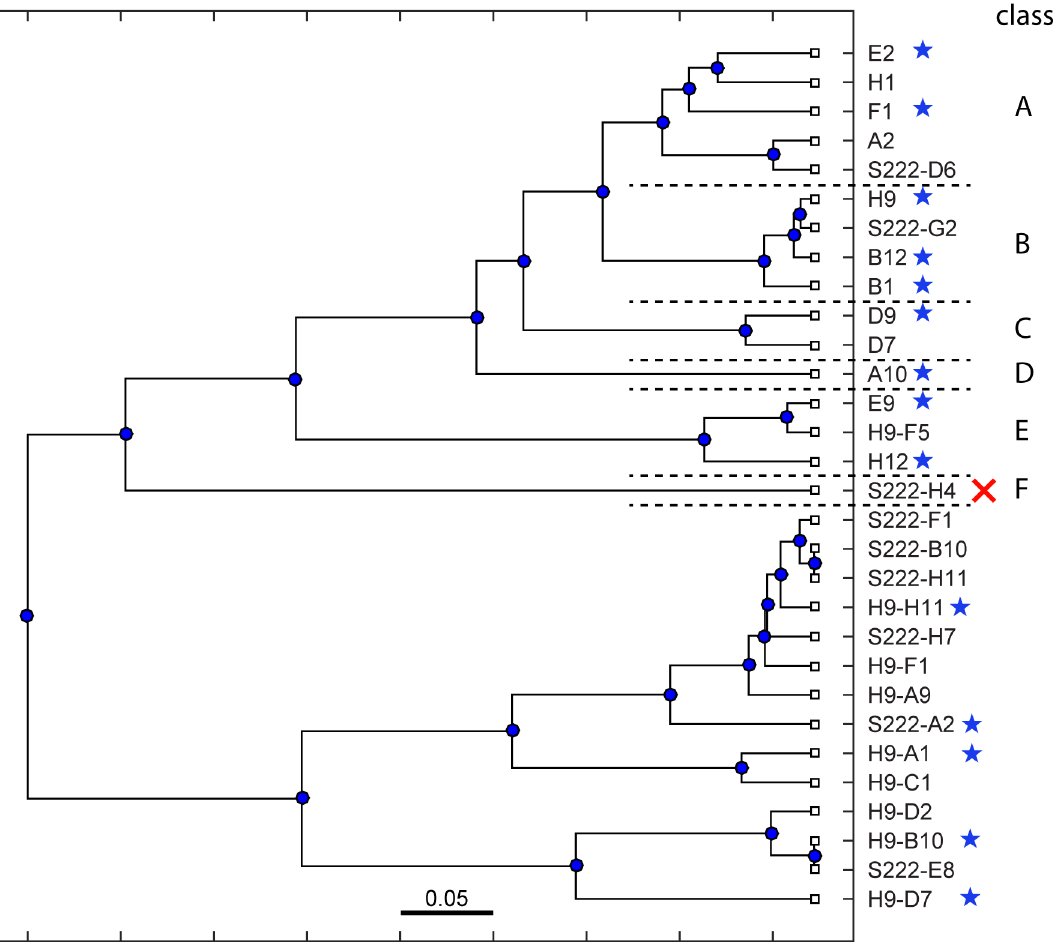
Fig 1. Phylogenetic tree of previously identified antibody sequences. Sequences of antibodies isolated by phage panning of the sequenced library in a previous work were grouped based on sequence similarity. A blue star indicates antibodies that were characterized in the previous work. The red X indicates an antibody that did not bind SEB. The scale bar represents a 5% difference in amino acid sequence. Single names refer to antibodies recovered by direct binding to immobilized antigen. Hyphenated names indicate those which were recovered by a sandwich method.